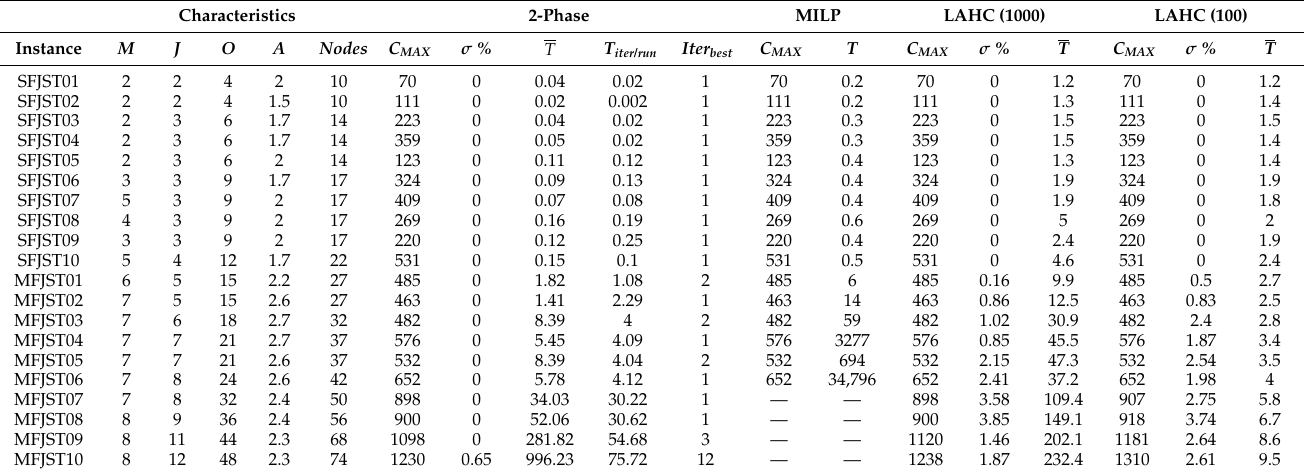
Table 6. Performance comparison of two-phase heuristic with existing approaches on Fattahi, Mehrabad and Jolai [29] test